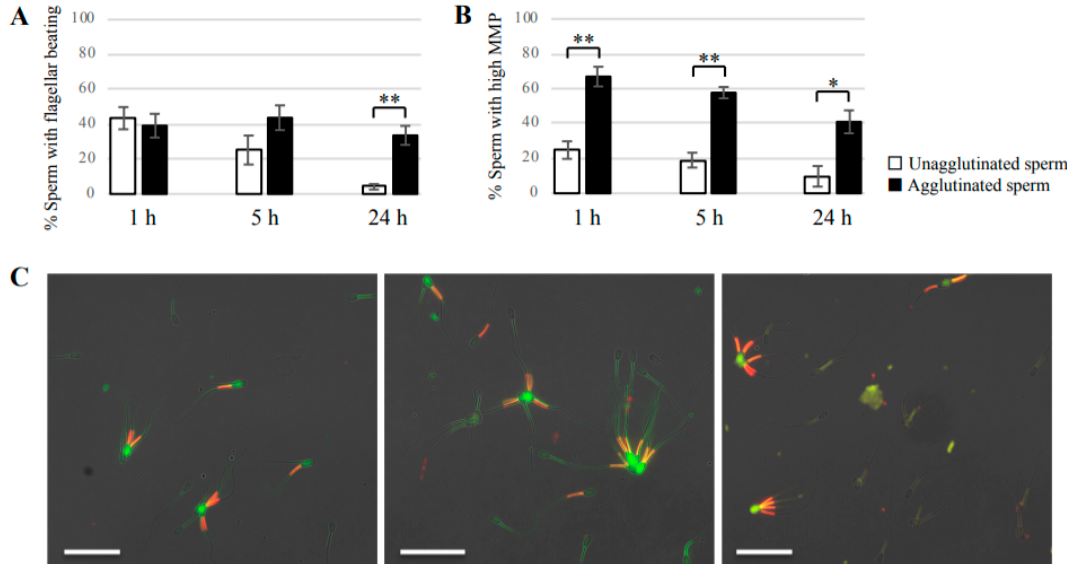
Figure 4. Motility and mitochondrial integrity of agglutinated and unagglutinated sperm. ( A ) The % of sperm with beating flagella in agglutinated or unagglutinated sperm. Bovine sperm were incubated for 1, 5, or 24 h in non-capacitation medium. At least 100 agglutinated sperm or 100 unagglutinated sperm were counted to determine the % of motile sperm. White bars show the % of unagglutinated sperm, and black bars show the % of agglutinated sperm. Data shown as the mean ± SE ( n = 4; ** p < 0.01). ( B ) The % of sperm with a high mitochondrial membrane potential (MMP) in agglutinated or unagglutinated sperm. Sperm MMP was evaluated by JC-1 staining at 1, 5, or 24 h of incubation in non-capacitation medium. White bars show the % with high MMP in unagglutinated sperm, and black bars show that of agglutinated sperm. Data shown as the mean ± SE ( n = 3; * p < 0.05; ** p < 0.01). ( C ) Representative images of sperm stained using the JC-1 assay. Left: image of sperm incubated for 1 h; Middle: sperm incubated for 5 h; Right: sperm incubated for 24 h. Green: sperm with a low MMP; Red or orange: sperm with a high MMP. Bars = 50 μ m.